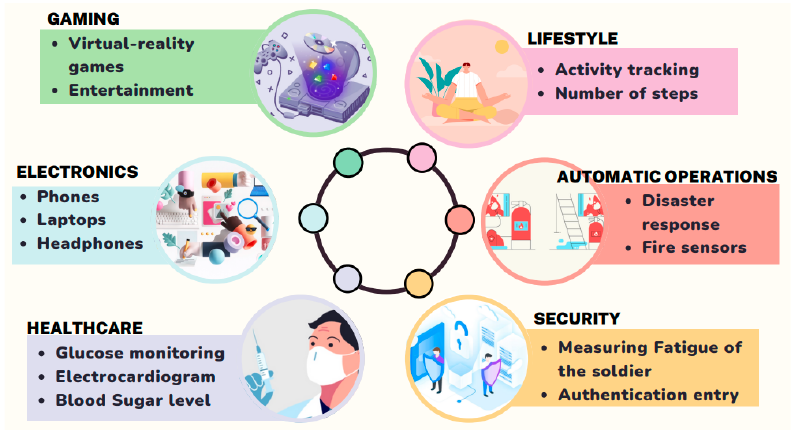
Figure 2. Applications of WBAN.